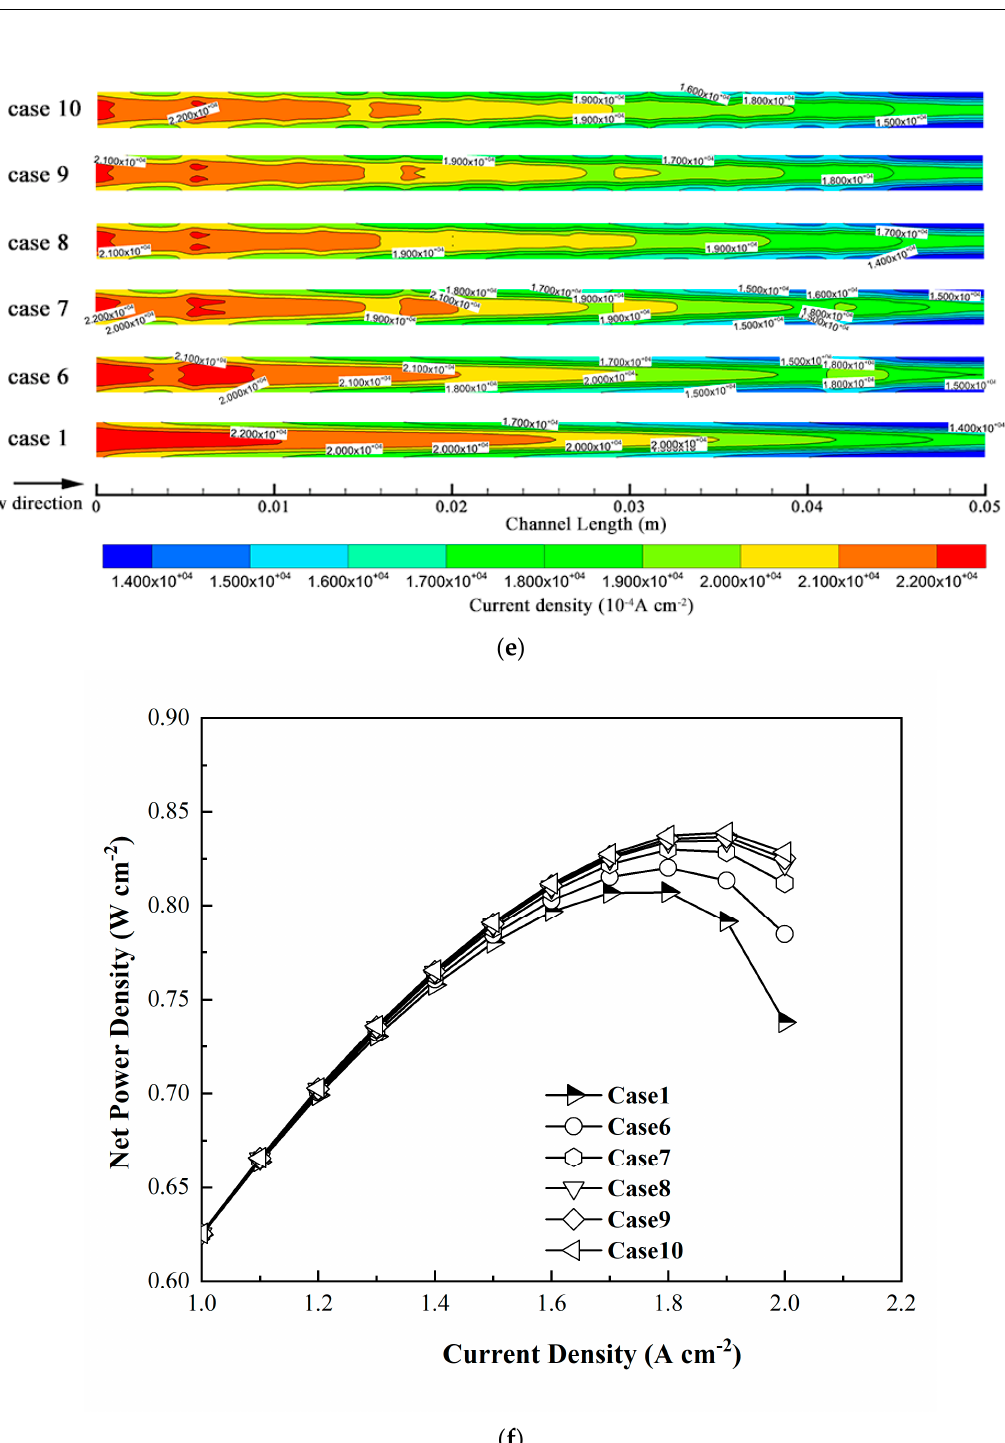
Figure 5. Performance of cases under different total dimensionless lengths of baffles. ( a ) Polarization curves and gross power curves. ( b ) Partially enlarged polarization curves. ( c ) Average oxygen molar concentration between GDL and CL. ( d ) Contours of oxygen molar concentration at the current density of 1.9 A·cm − 2 . ( e ) Contours of the current density distribution at the current density of 1.9 A·cm − 2 . ( f ) Net power density curves.